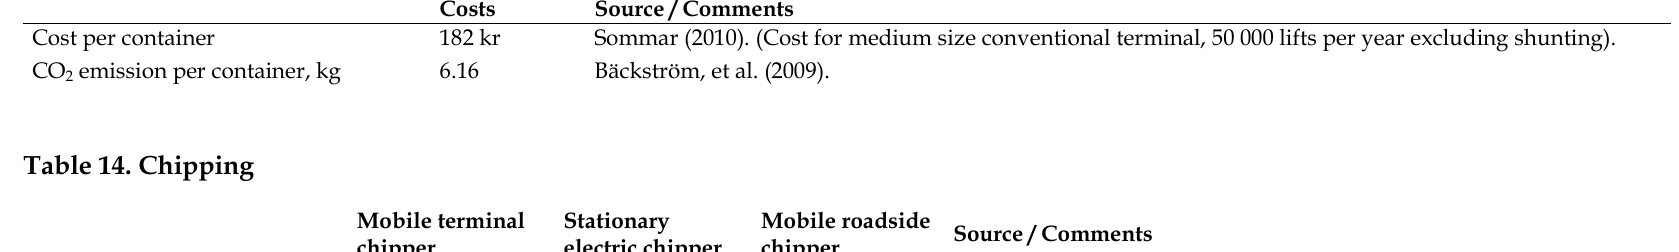
Table 13. Conventional intermodal terminal